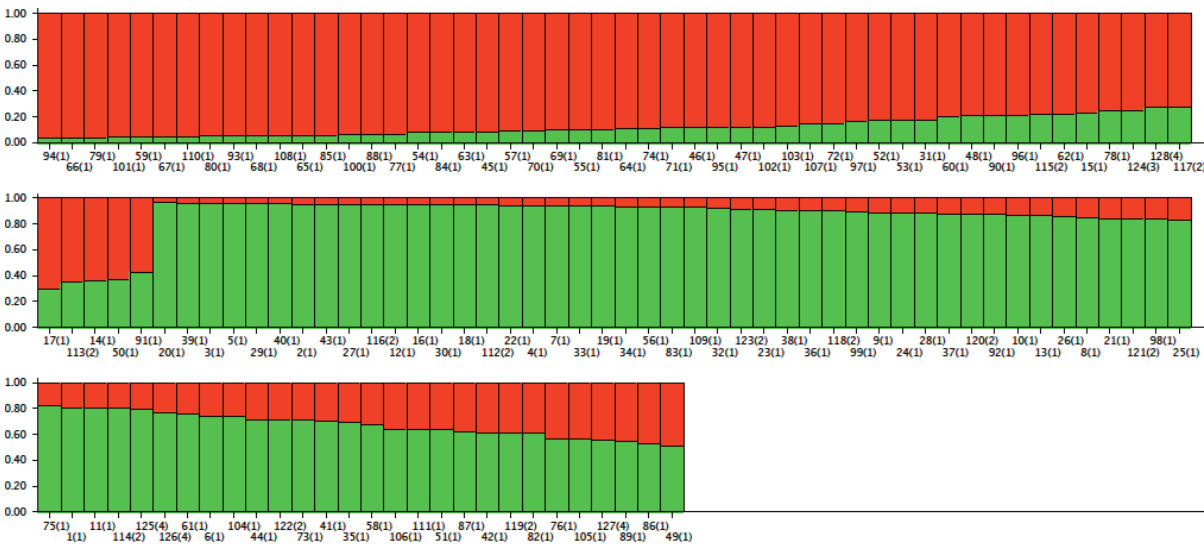
Figure 2. Q-plot of STRUCTURE analysis grouping the rice genotypes in two major groups, based on K = 2.